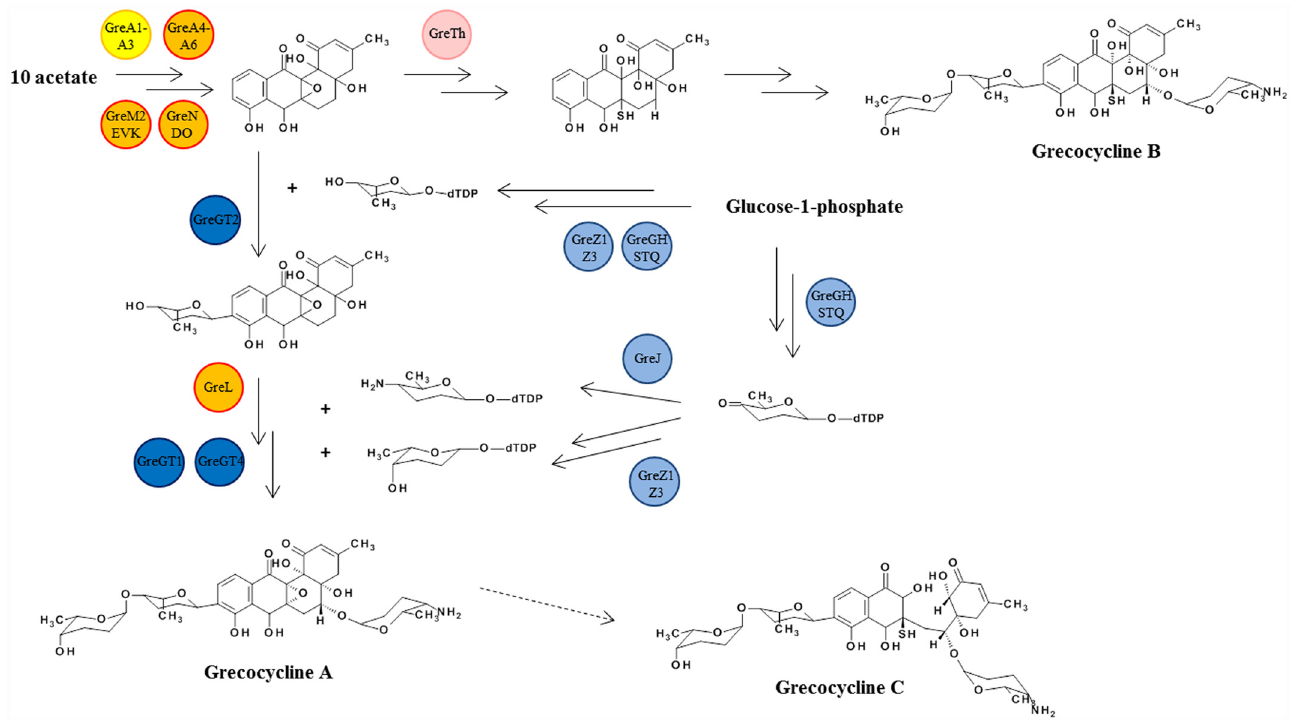
Fig 3. Proposed biosynthesis of grecocyclines. In circles are indicated enzymes putatively involved in particular biosynthetic steps.